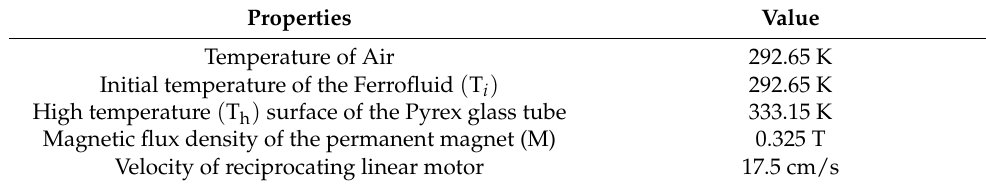
Table 2. Operating and boundary conditions applied in this study.